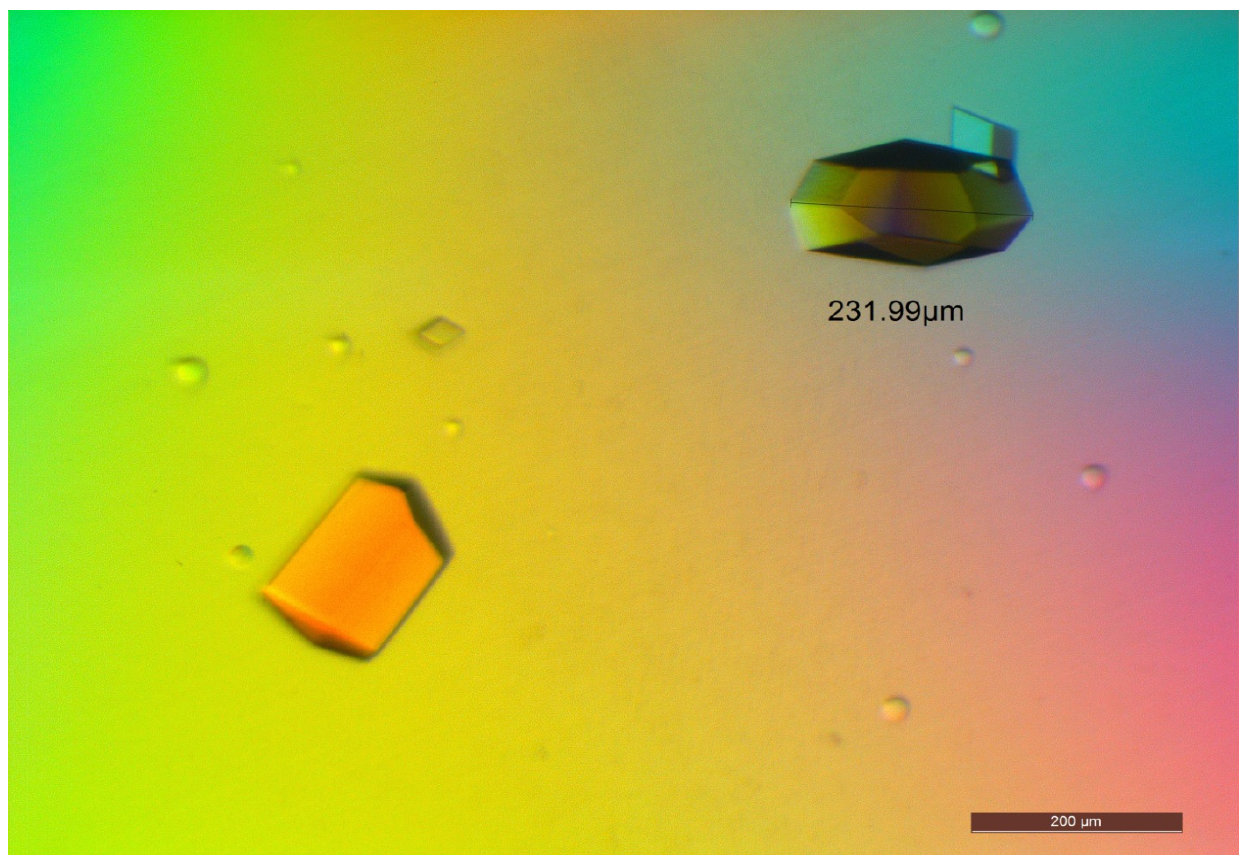
Figure 7. D311E lipase crystal grown using sitting drop method with 0.1 M MES pH 5.5, 0.1 M Sodium phosphate, 0.1 M Potassium phosphate, and 1.5 M NaCl as precipitant